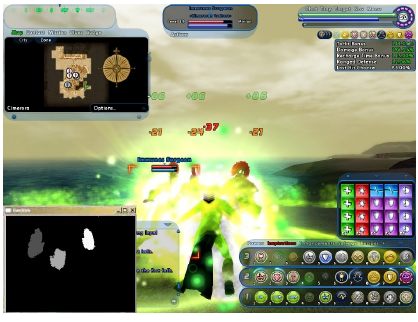
Fig. 4. Entertainment application controlled by